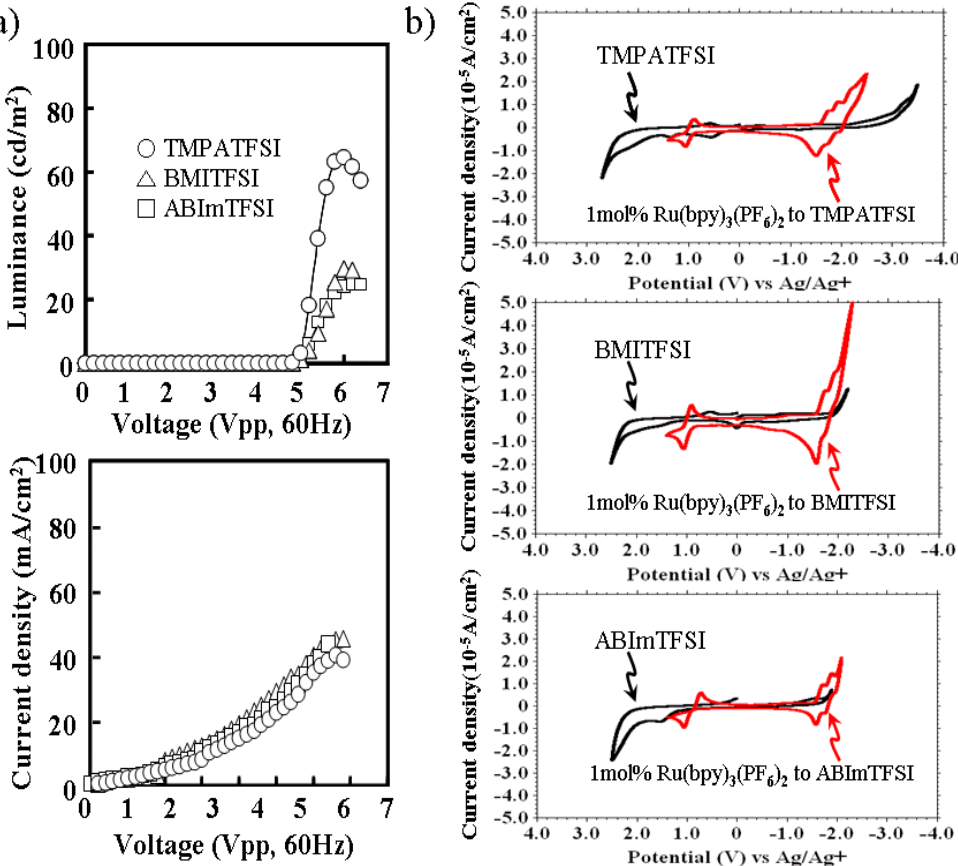
Figure 2. (a) Characteristic of luminance and current density of voltage applied to ECL liquid for different ionic liquids. (b) Cyclic voltammograms of ECL liquid and ionic liquid for each ionic